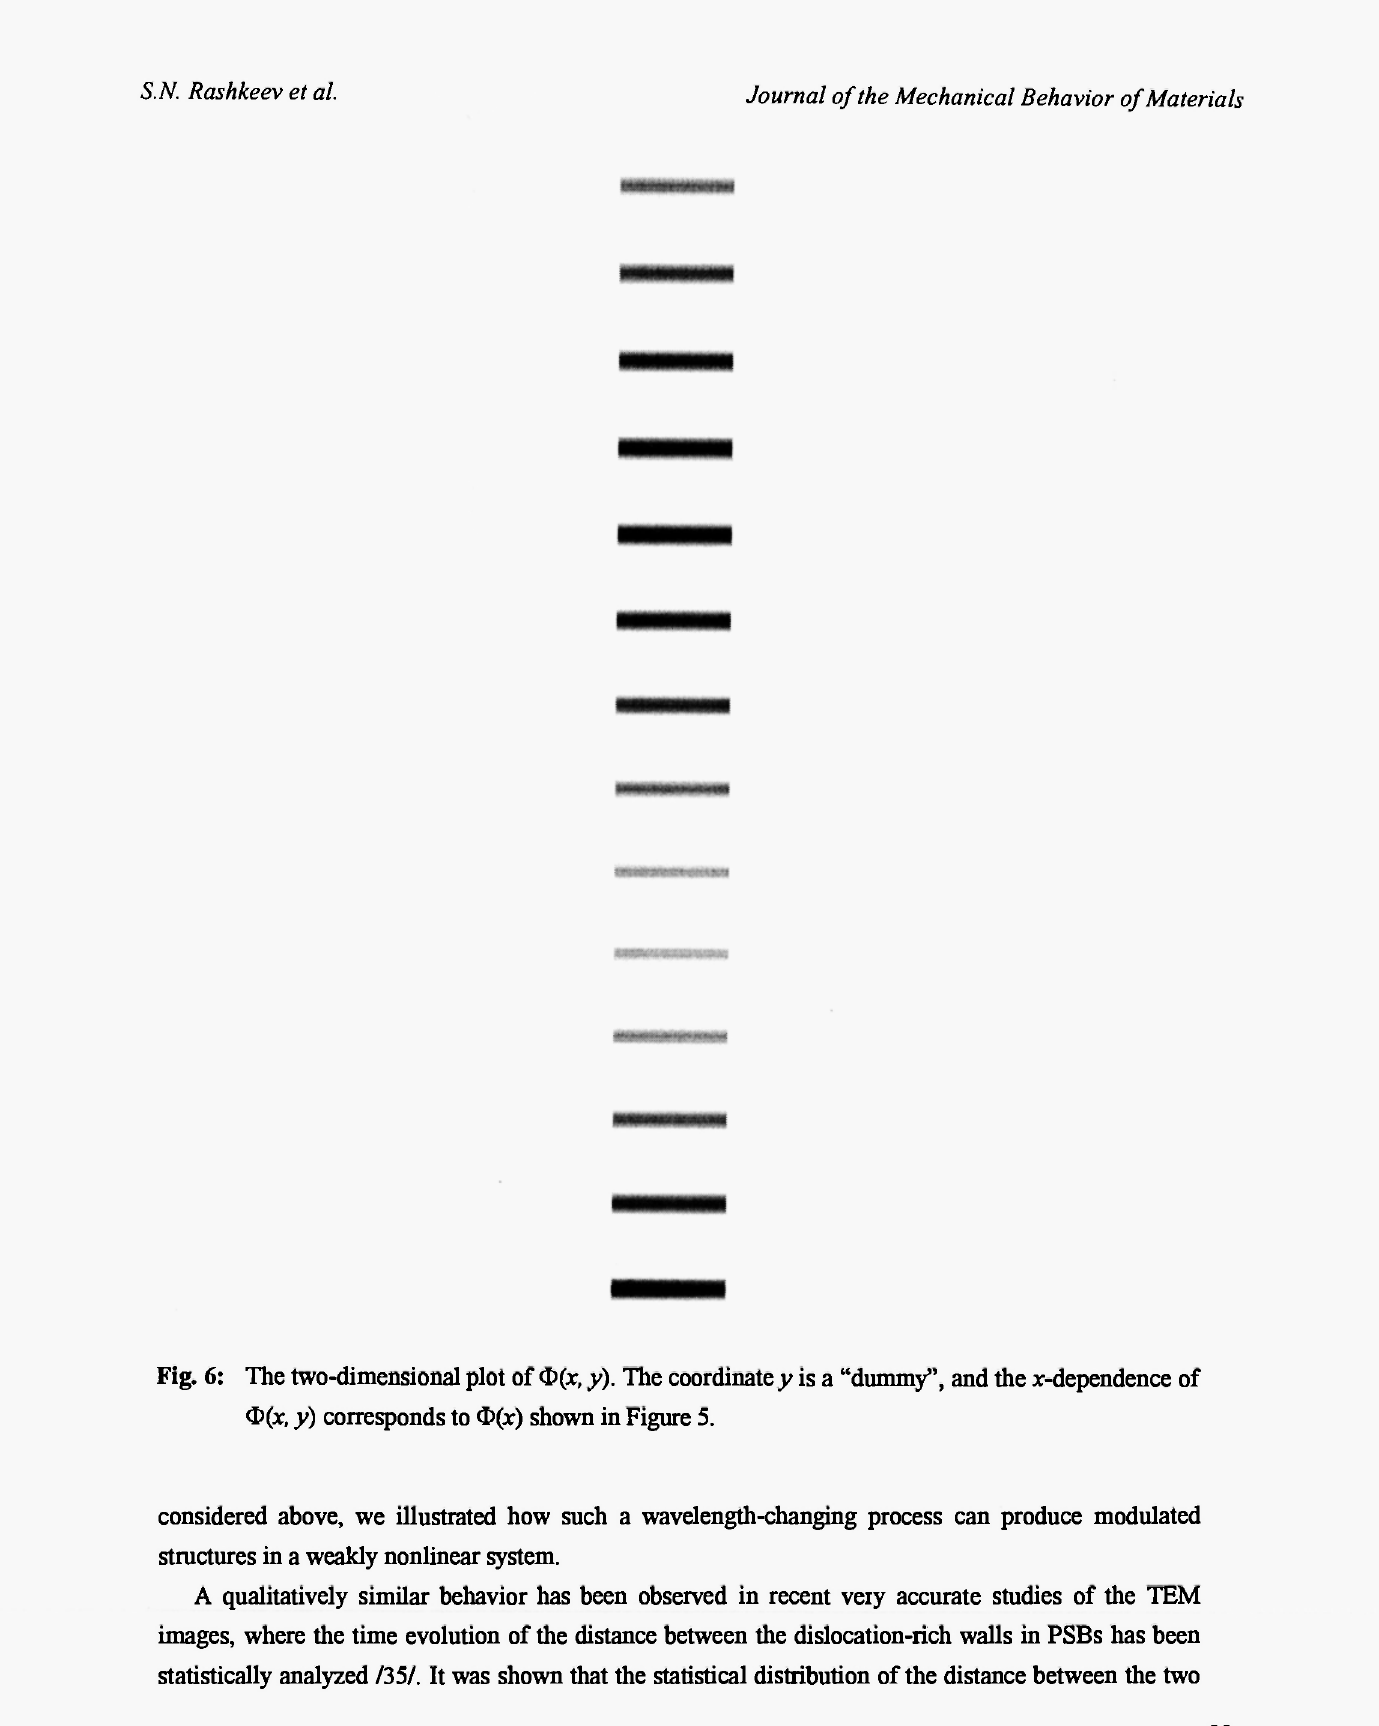
Fig. 6: The two-dimensional plot of Φ(χ, >>)• The coordinate y is a "dummy", and the x-dependence of Φ(χ, y) corresponds to Φ(χ) shown in Figure